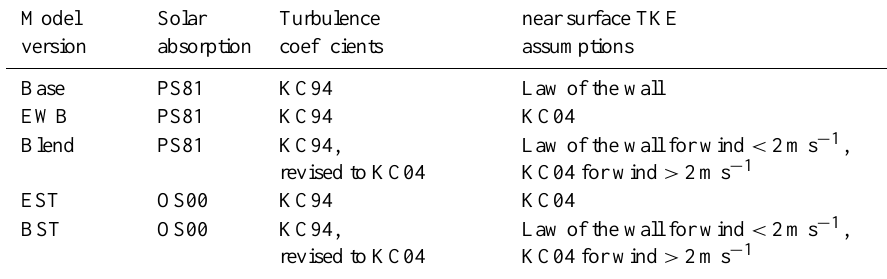
Table 2. Summary of the five model versions used for